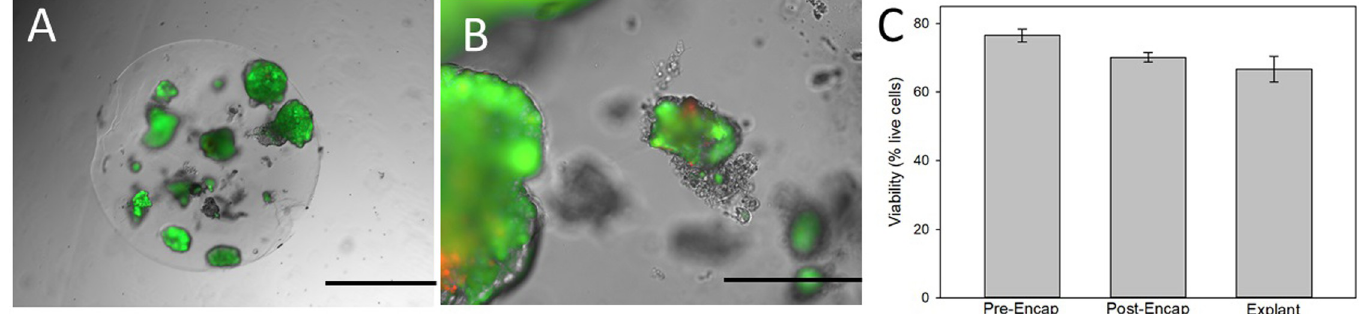
Fig 8. Viability of cells from explanted microspheres. A) A typical microsphere following retrieval from a diabetic dog shows intact encapsulated islets stained for viability (green). Scale bar = 500 μ m. B) A higher magnification of a microspheres indicates the viability within the islets with rare red staining for dead cells, while the majority of the cells were green (alive). Scale Bar = 40 μ m. C) Calcein staining was calculated as a percentage of the total cellular area and compared with the viability of the canine islets prior to encapsulation, after encapsulation (before transplant) and after the transplantation (explant). There were no statistical differences between the groups.